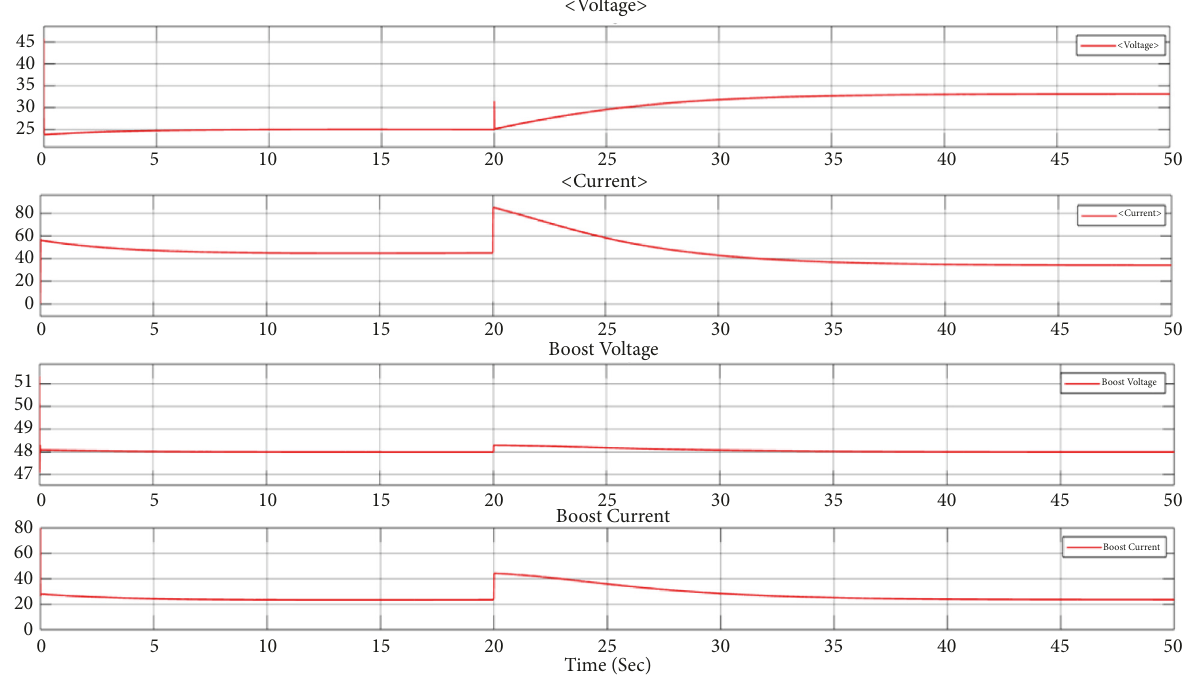
Figure 18: The voltage and current of fuel cell and Boost converter.